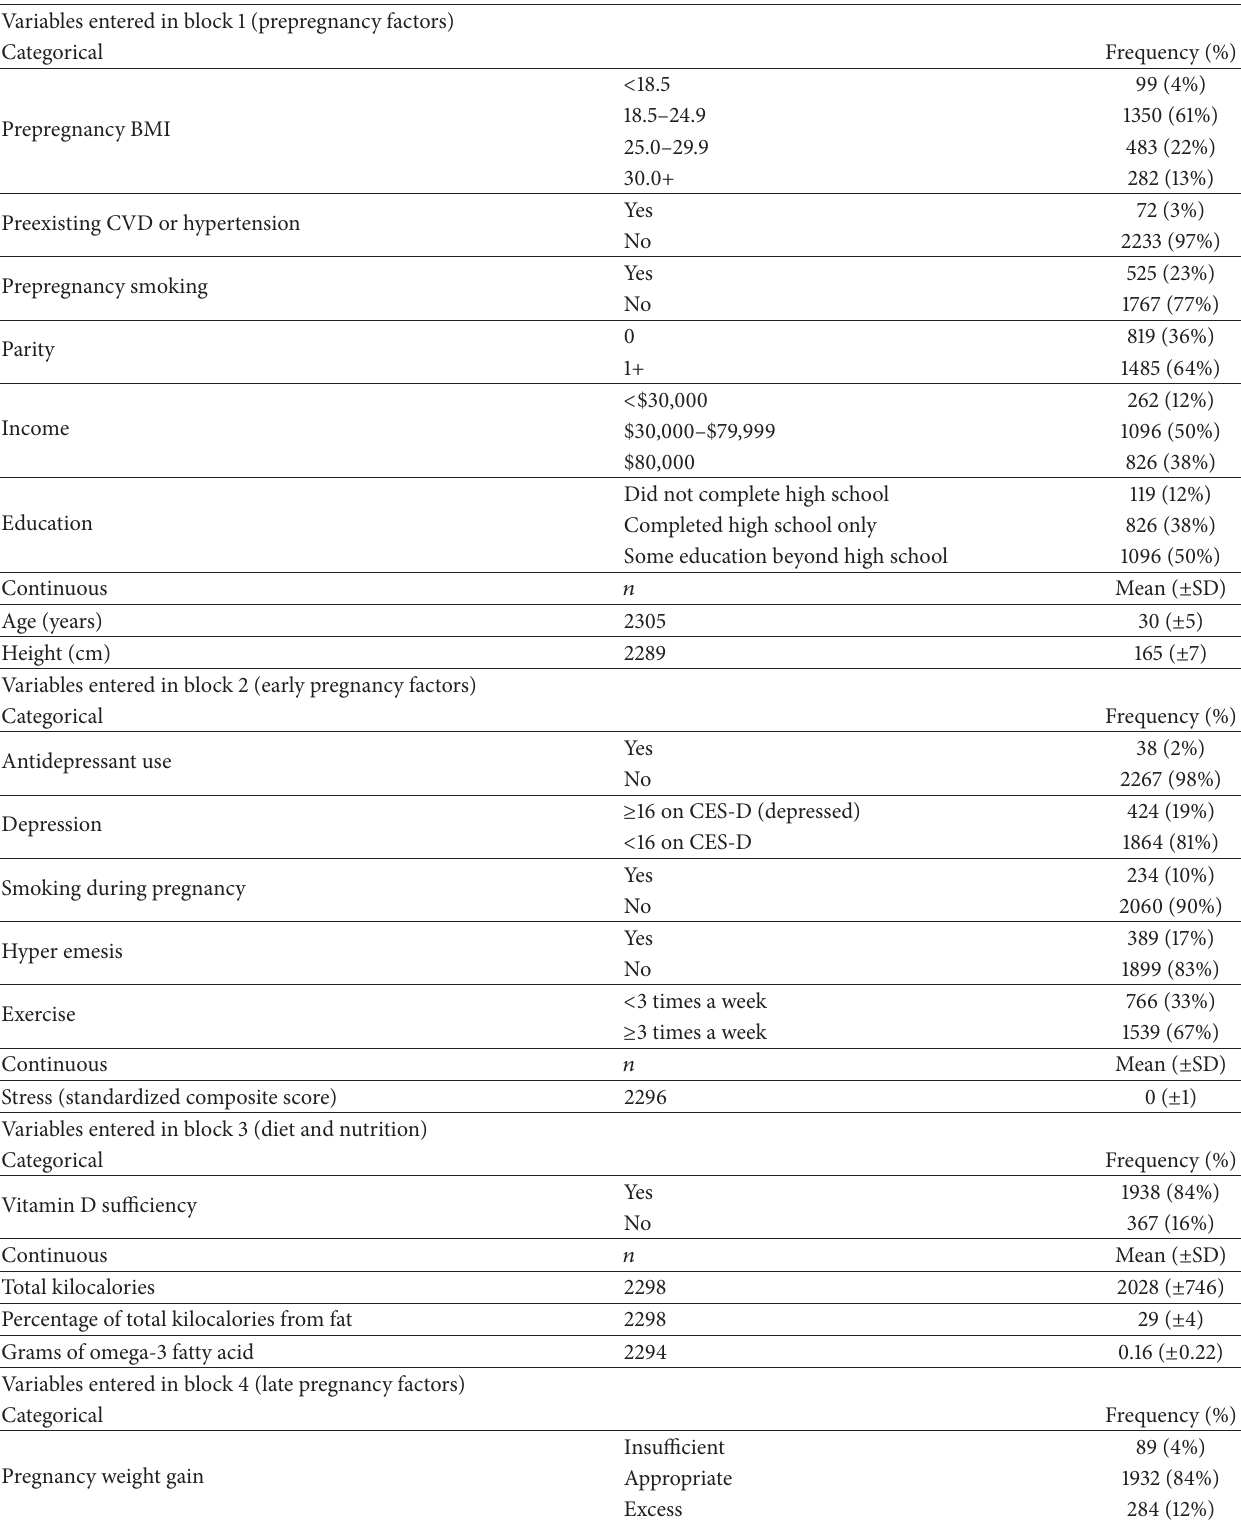
Table 1: Frequency and order of variable entry in